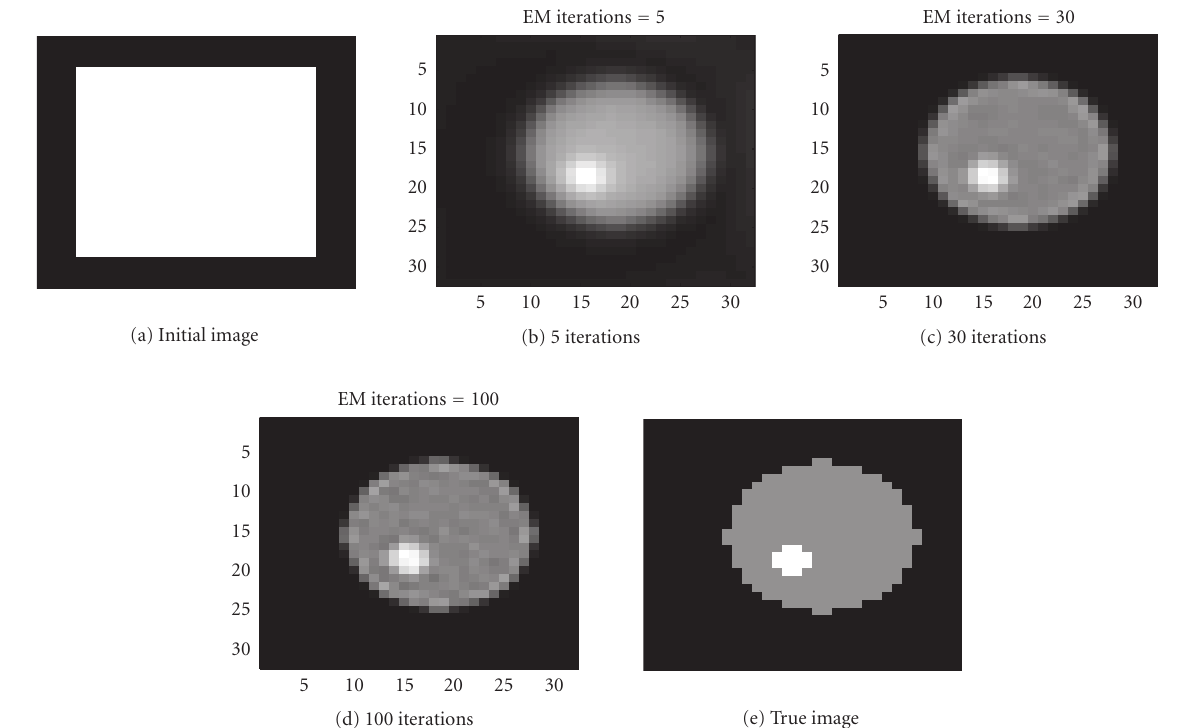
Figure 3: Evolution of a two circles using the EM algorithm.